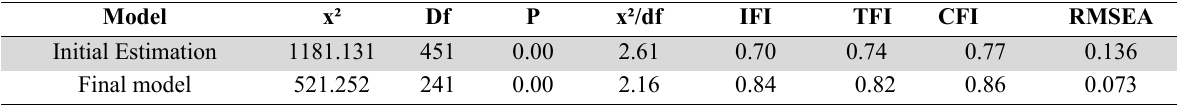
Measurement model fit indices